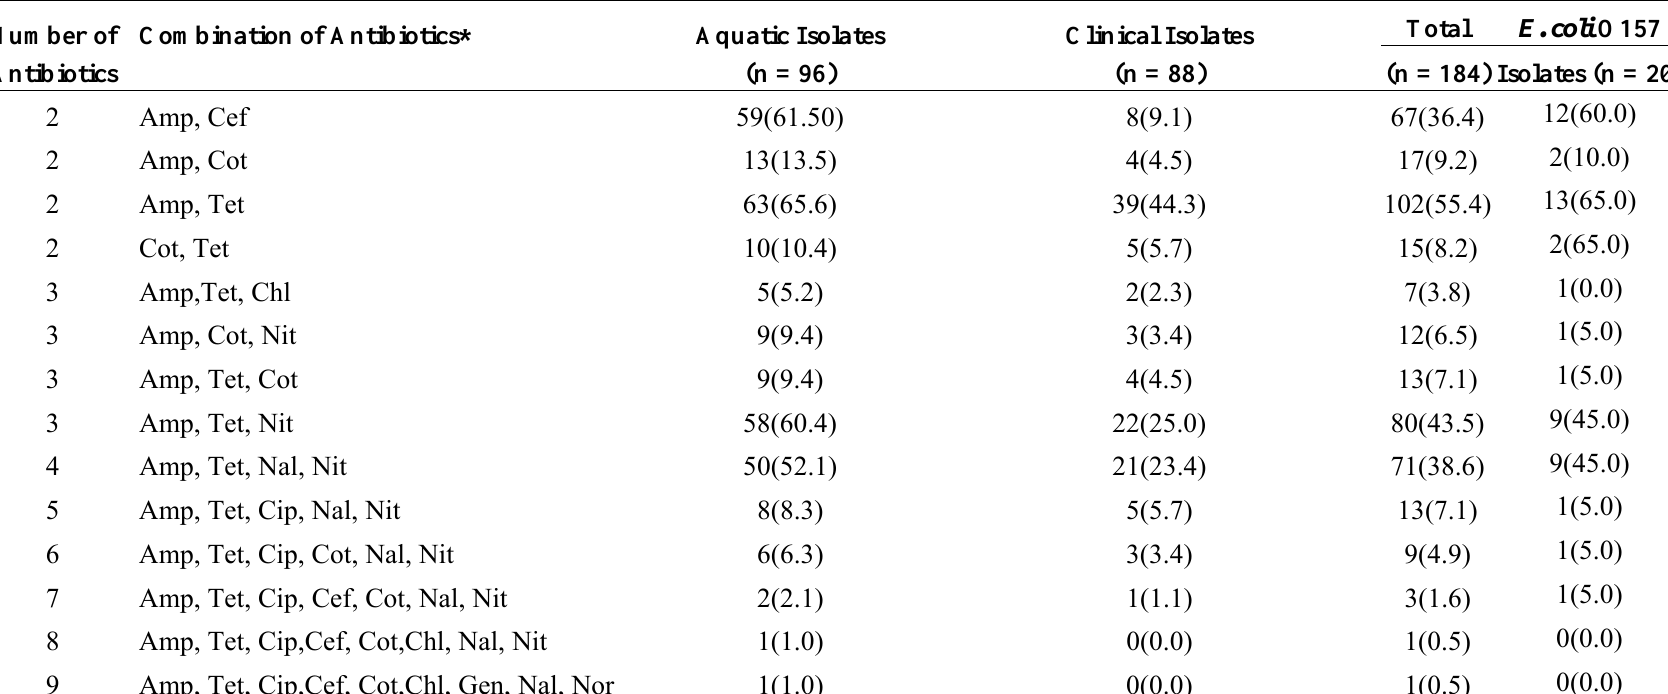
Table 3. Resistance Patterns of Aquatic and Clinical in E. coli